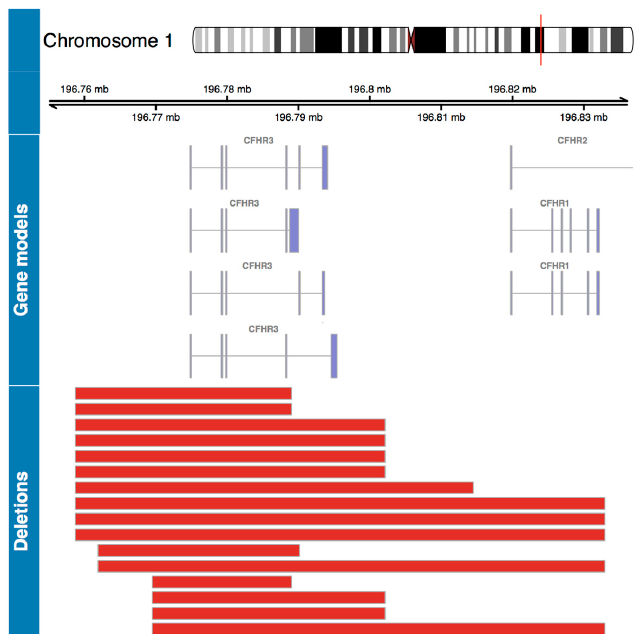
Figure 2. Genomic map for statistically significant deletions in severe patients. The top panel shows the chromosome containing the associated regions with the coordinates, and the subregion of interest marked in red. The second panel shows the gene models for the alternative transcripts of the CFHR genes located in the region of interest. The bottom panel shows the size of each CNV deletion along the same genomic coordinate, each red line corresponds to a deletion in a patient.